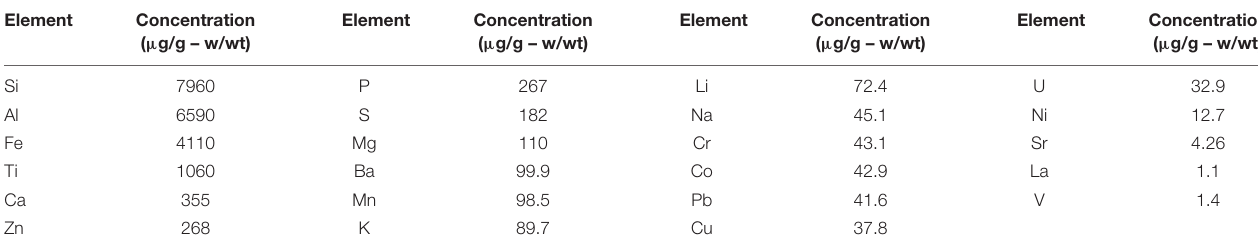
TABLE 1 | Elemental concentration ( µ g/g – w/wt) of precipitates collected throughout the spent nuclear storage basin. Element Concentration Element Concentration ( µ g/g – w/wt) ( µ g/g – w/wt)